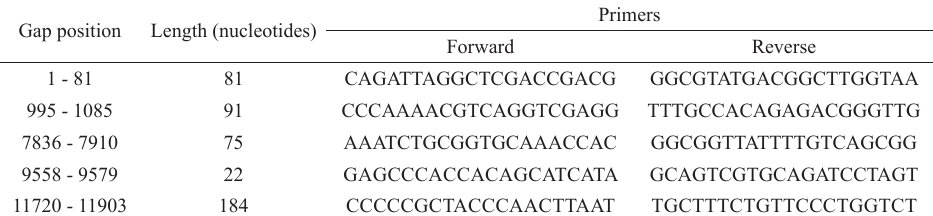
Table 2. Positions and lengths of the five gaps in the mitogenome assembled using mitochondrial transcripts sequenced using Illumina HiSeq2500. These gaps were filled using conventional PCR and Sanger sequencing with the species-specific primers listed.